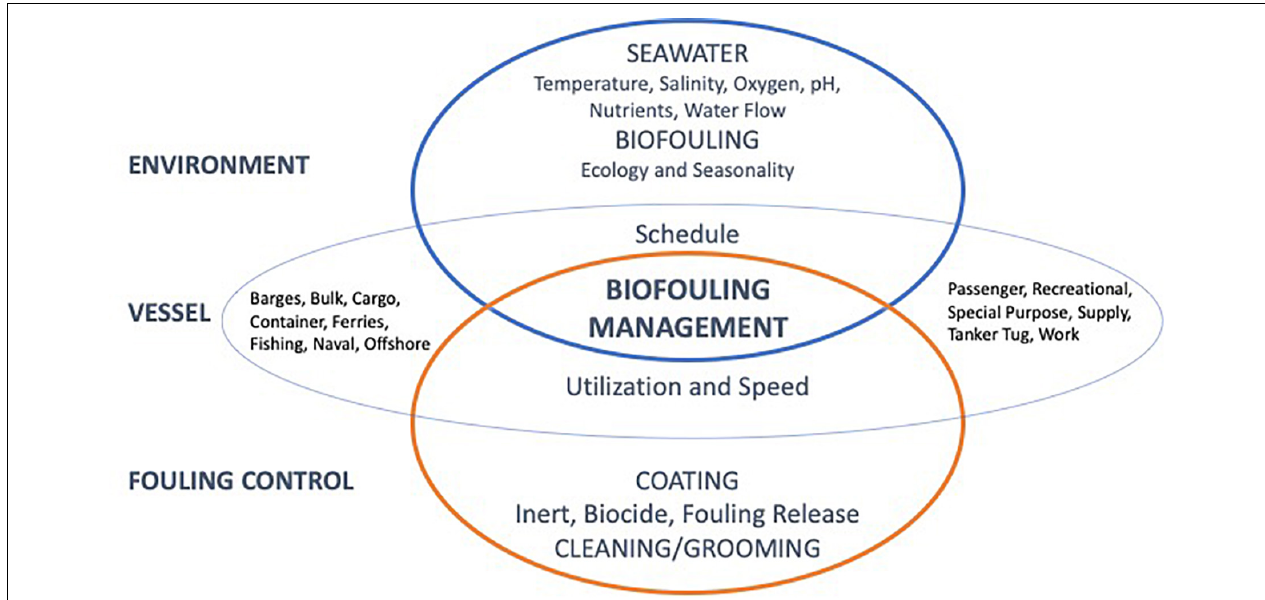
FIGURE 1 | Factors influencing the management of biofouling on ships.